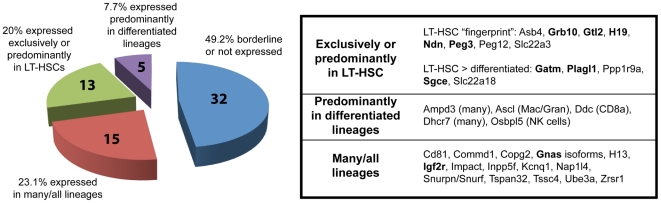
Summary of microarray analysis of imprinted gene expression in hematopoiesis.Microarray data from mouse LT-HSCs and differentiated lineages [11] were analyzed for the expression of known imprinted genes. The chart (left) shows the distribution of genes according to the specificity of their lineage distribution; the individual genes in each expression category are listed to the right (genes previously identified as being part of the IGN, as defined by Varrault et al. [16] are noted in bold-face type). Supplementary information is provided in Table S1, showing the description of the core IGN genes in this study.